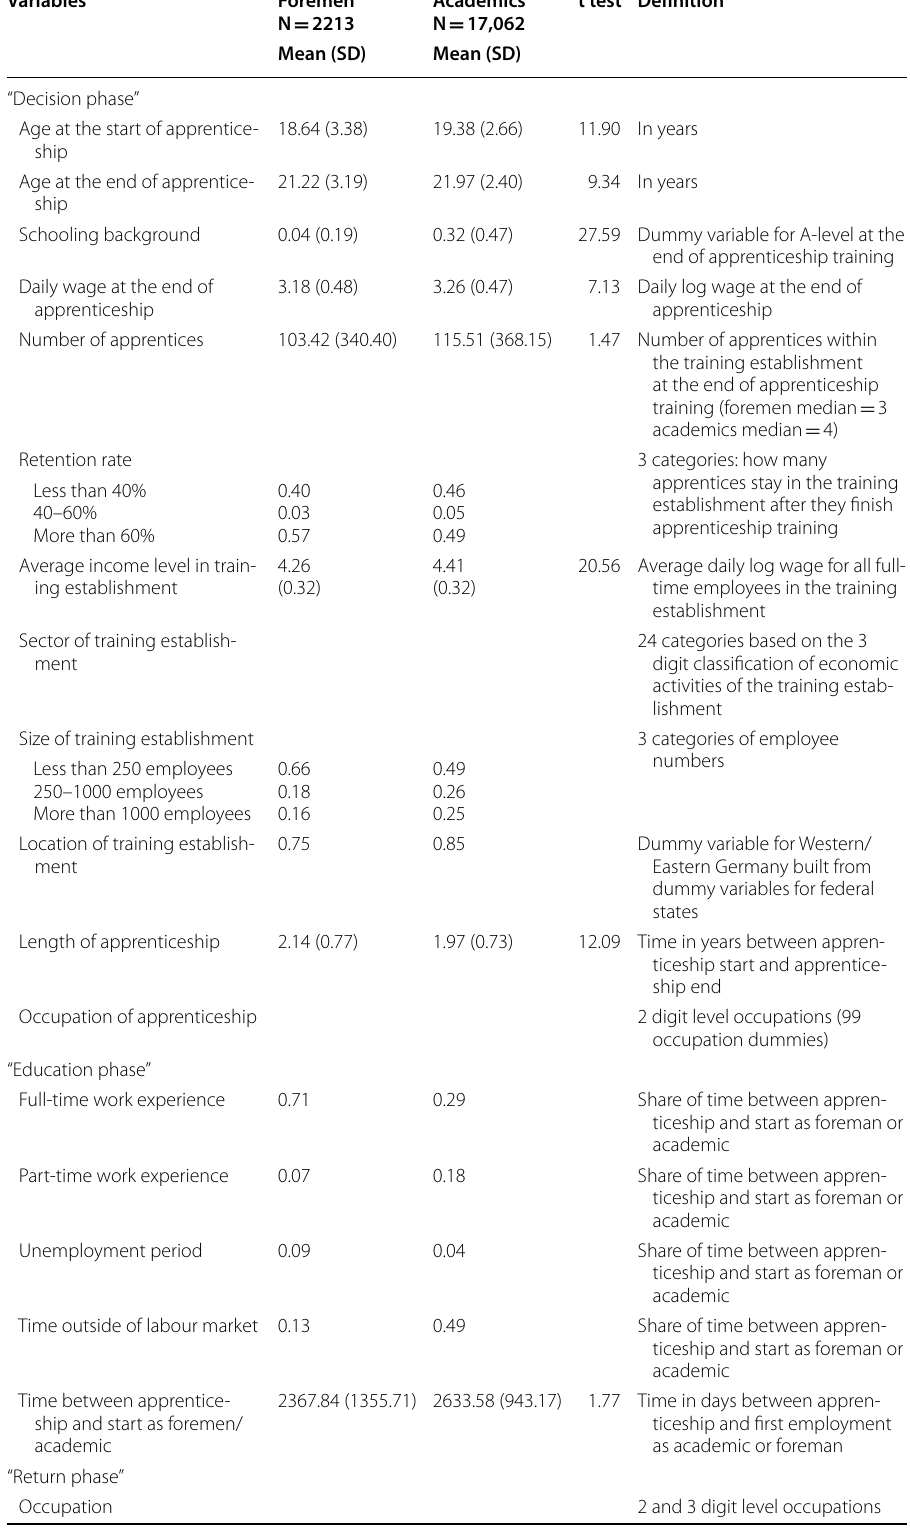
Table 1 Descriptive statistics before